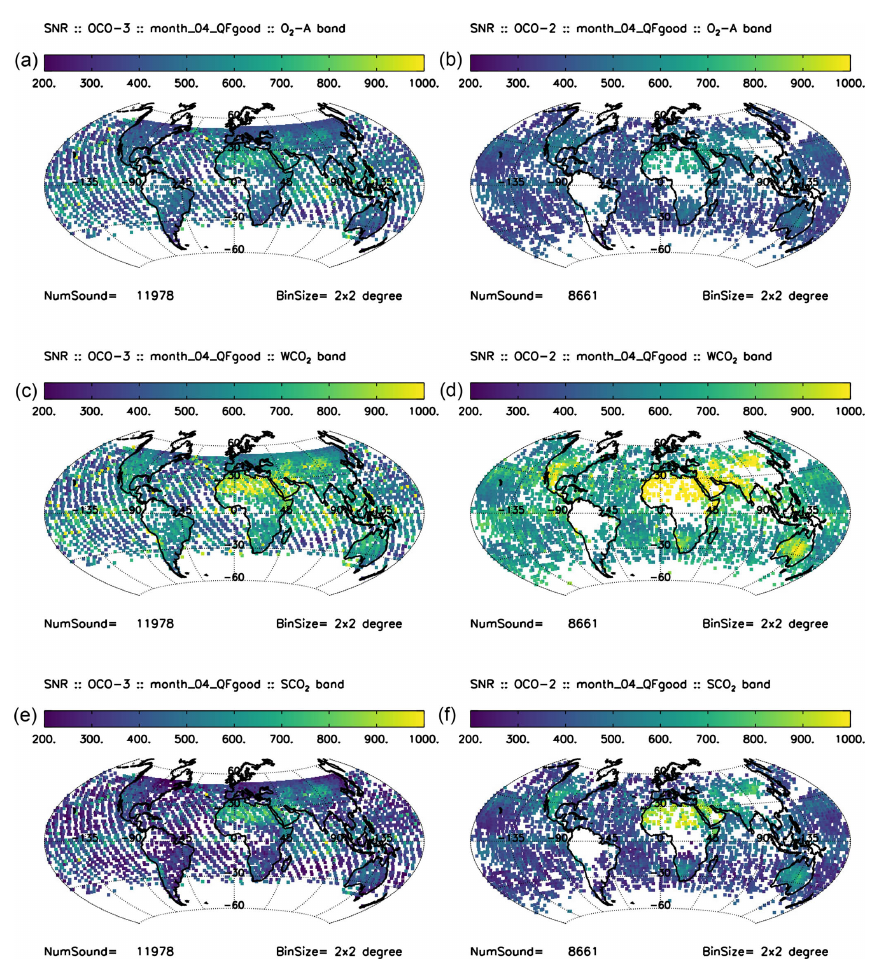
Figure 9. Maps comparing the SNR of OCO-3 (a, c, e) to OCO-2 (b, d, f) for each spectral band (rows) for the month of April binned in 2 ◦ latitude bins. Both datasets have been filtered using the L2FP quality flag. The operational OCO-2 data have been down-selected to include a single footprint and one sounding every 10s to provide a fairer comparison against the OCO-3 simulations. The OCO-2 data also include both nadir and glint land soundings in addition to